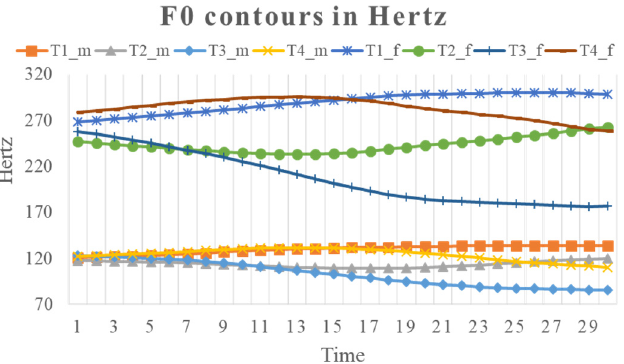
Figure 2. Mean time-normalized syllable-sized f 0 contours of four Mandarin tones, averaged sepa- rately for female and male speakers.